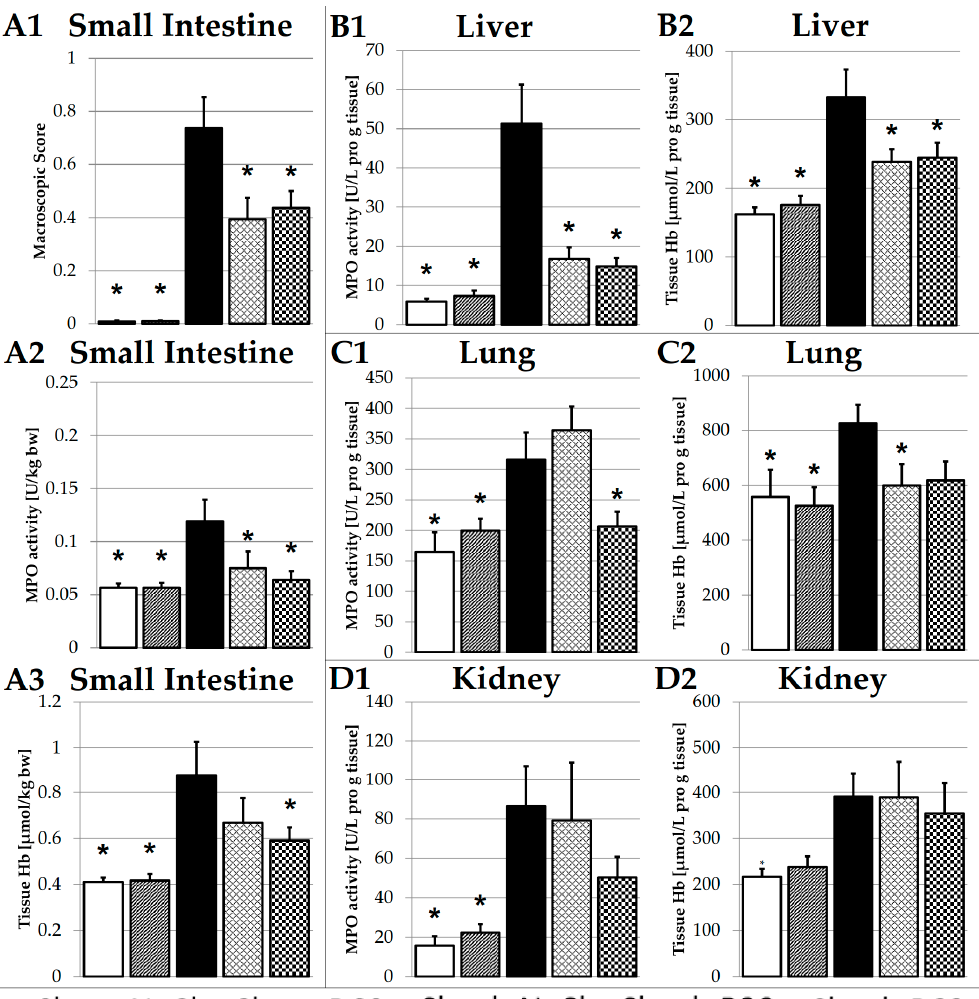
Figure 3. Effect of continuous intravenous infusions of solvent-free low-dose resveratrol on tissue parameters of organ injury subsequent to severe hemorrhagic shock in rats. Rats underwent severe hemorrhage (30 min shock induction, 60 min shock phase), then were resuscitated within 30 min with the withdrawn blood and lactated Ringer’s equal to twice the volume of the withdrawn blood in the absence (Shock-NaCl) or presence of resveratrol (20 or 60 µ g/kg × h until the end of the experiment; Shock-R20, Shock-R60) and observed for a further 150 min. Sham animals received either pure 0.9% NaCl solution (Sham-NaCl) or the higher resveratrol dose (Sham-R60). The macroscopic injury score of the small intestine ( A1 ), as well as tissue myeloperoxidase (MPO) activity and hemoglobin (Hb) content of the small intestine ( A2 , A3 ), the left lobe of the liver ( B1 , B2 ), the left lung lobe ( C1 , C2 ) and the left kidney ( D1 , D2 ) were determined instantly after the animals were sacrificed at the end of the experiment. Shown are mean values ± SEM ( n = 8 animals per group). * p < 0.05 (vs. Shock-NaCl).